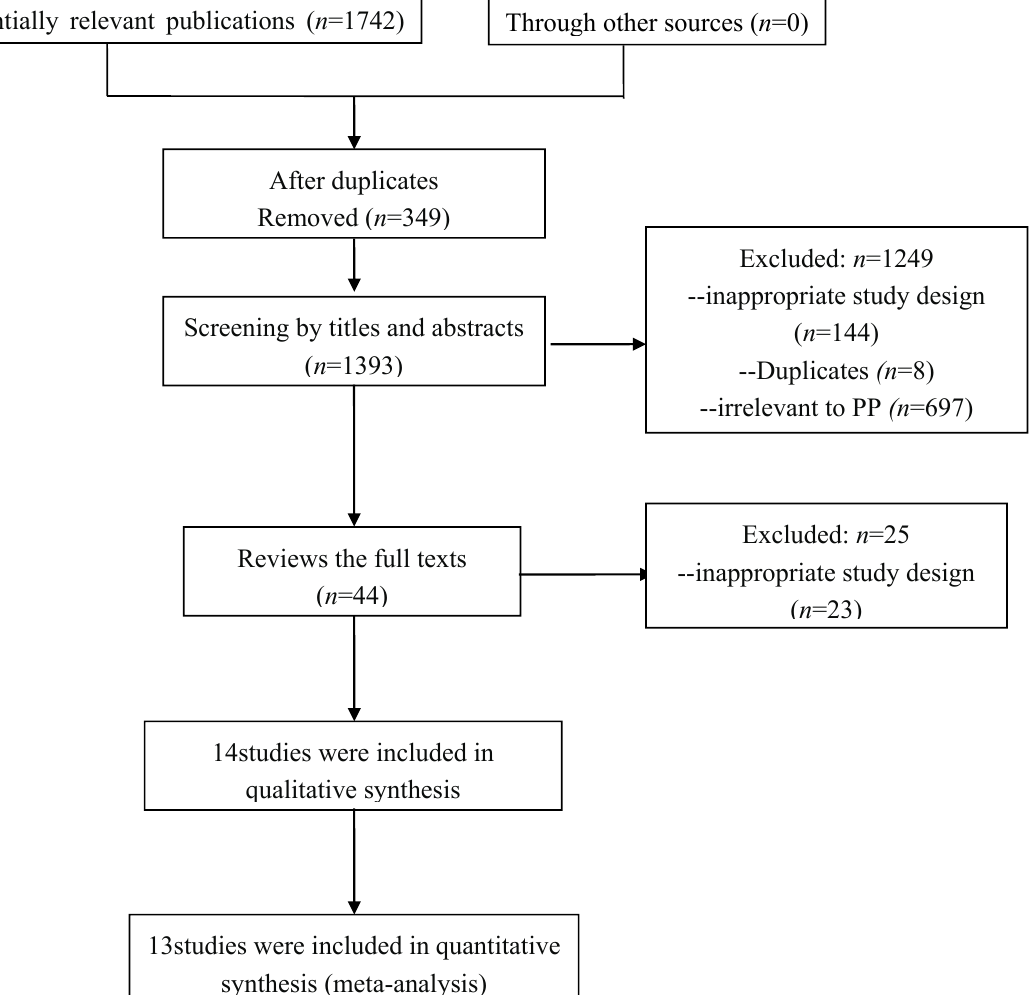
Figure 1. Flow Diagram of the Literature Search.